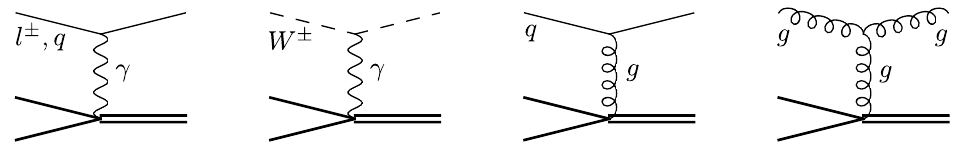
Figure 1 . Graphic shows electrically or color charged coannihilation examples where bound states are formed via bath-particle scattering. The amplitudes for these processes are divergent in the forward scattering direction of the bath particles. Parallel black solid lines represent the bound state, while open lines correspond to the initial two-particle scattering